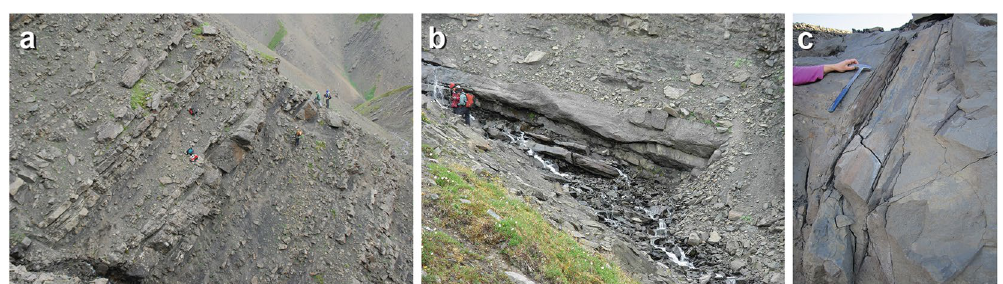
Figure 4. Outcrop photographs of lower Cantwell Formation in study area. ( a ) Representative exposure of rock unit, note the abundance of fine-grained strata. ( b ) An example of a splay channel within study area. ( c ) Fossil tree preserved within splay